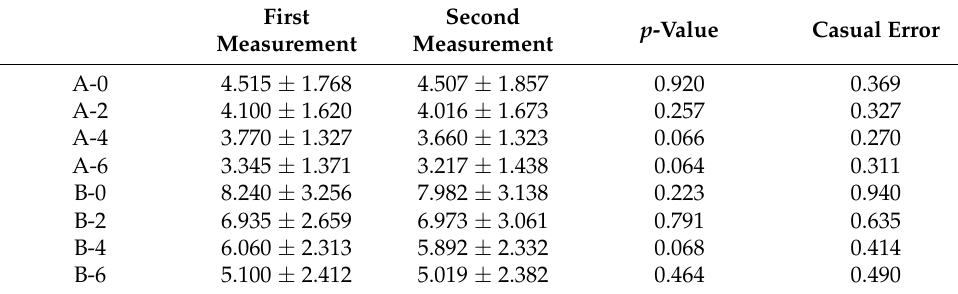
Table 2. Analysis of error of the method using the paired t -test and Dahlberg’s